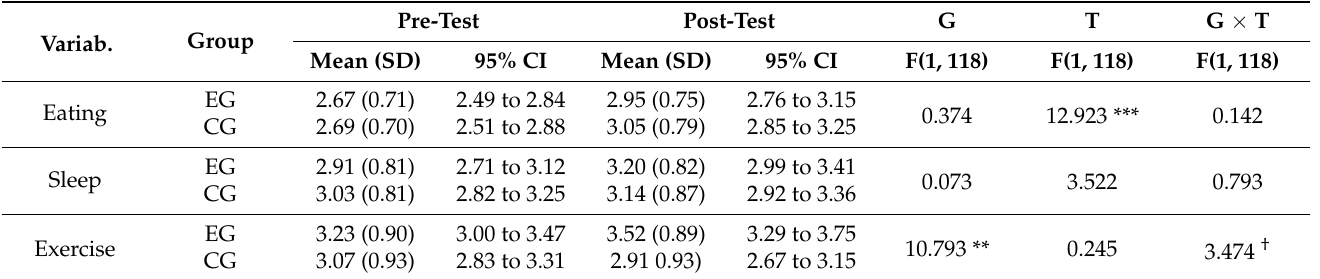
Table 5. Changes in health behavior over the